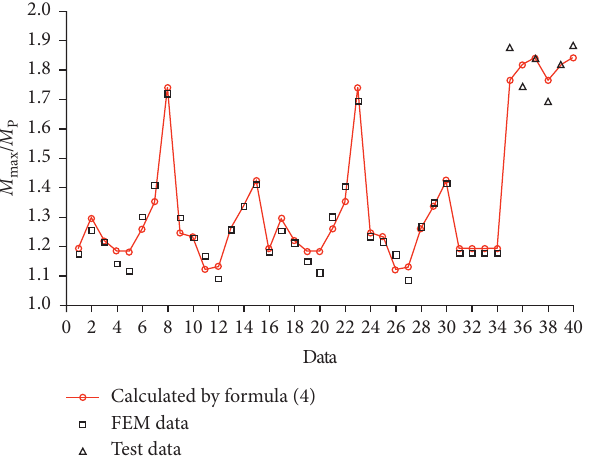
Figure 19: Results by formula (4), the pseudostatic test, and finite element